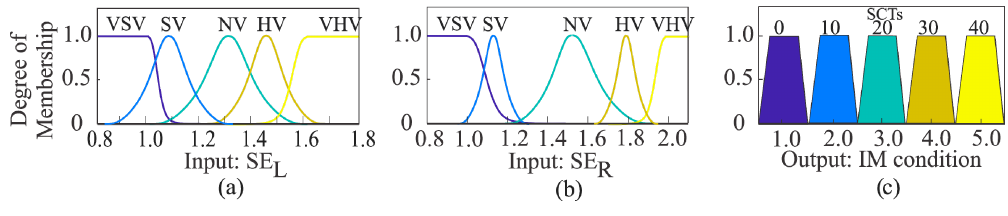
Figure 9. Membership functions for ( a ) SE L and ( b ) SE R and ( c ) FL outputs. Table 2. Rules for the proposed FL system.